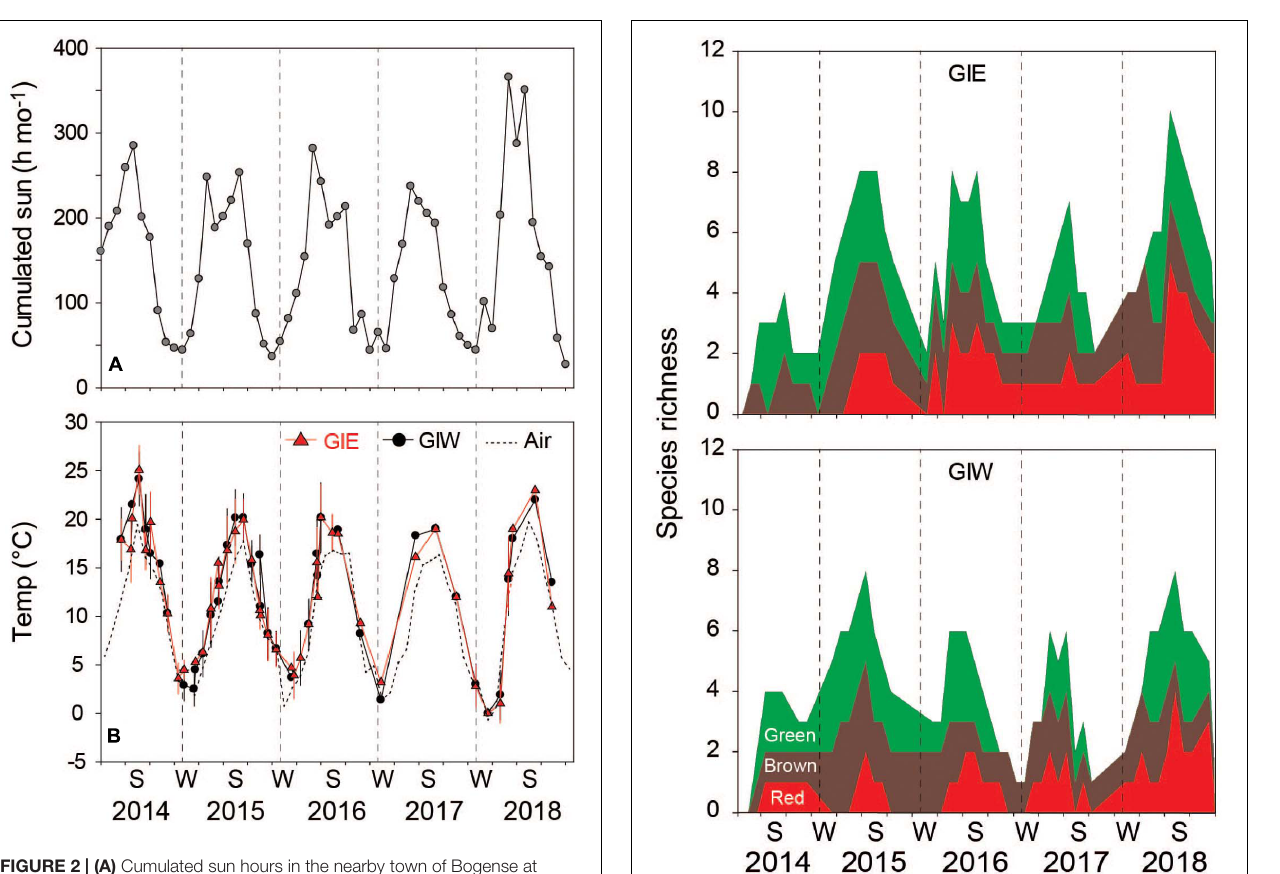
FIGURE 2 | (A) Cumulated sun hours in the nearby town of Bogense at monthly intervals from March 2014 to December 2018 (from Danish Meteorological Institute, DMI). (B) Monthly average water temperature in Gyldensteen Coastal Lagoon obtained from HOBO temperature loggers from June 2014 to August 2016 and manually 4 times each year after that. Dotted line indicates air temperature in the nearby town of Bogense achieved from DMI. Lines and symbols in red represent station GIE and in black represent station GIW.